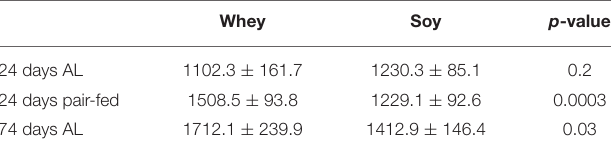
TABLE 2 | Serum IGF-I levels